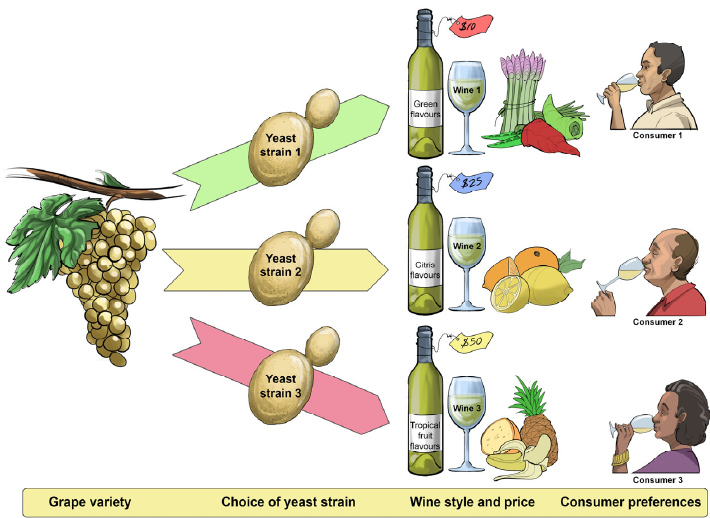
Figure 13. Different strains of Saccharomyces cerevisiae produce secondary flavour ‐ active metabolites and impart different aromas to wine. Not all wine yeast strains are equal. Juice from the same grapes will deliver quite different wines, depending on the choice of S. cerevisiae strain. Because there are huge differences in consumer preferences, shaped by such variables as ethnicity, gender and age, it is important for winemakers to know which yeast to choose if they want to tailor their wines for particular markets. We are only just beginning to understand the genetics underpinning the way different wine yeast ‘shape’ wines.